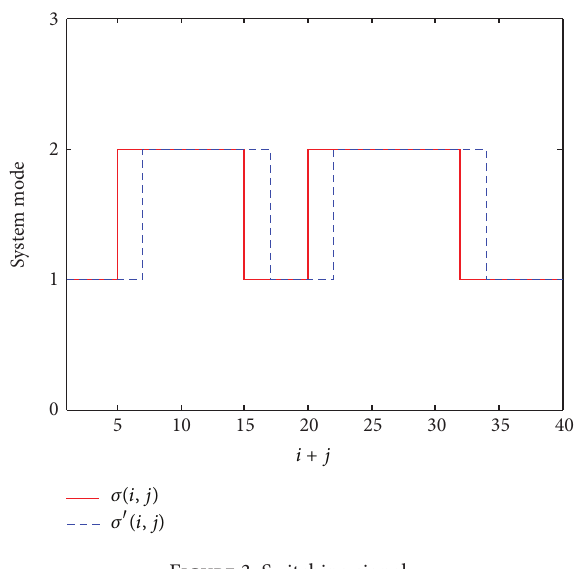
Figure 3: Switching